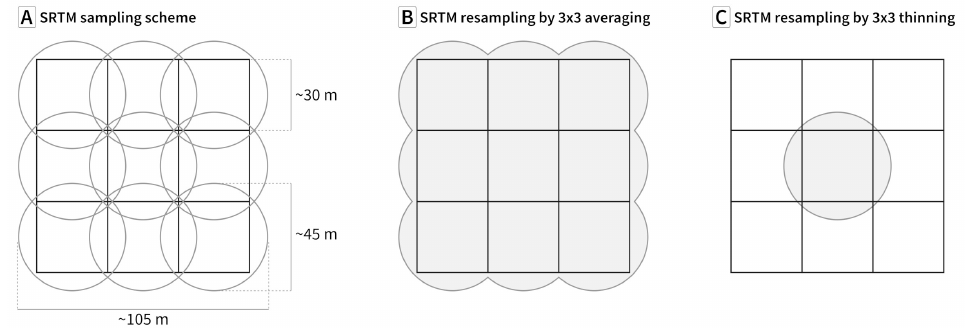
Figure 3. ( A ) SRTM sampling for 1 (cid:48)(cid:48) cells with the values actually representing a slightly larger area, and resampling to 3 (cid:48)(cid:48) cells by either averaging ( B ) or thinning ( C